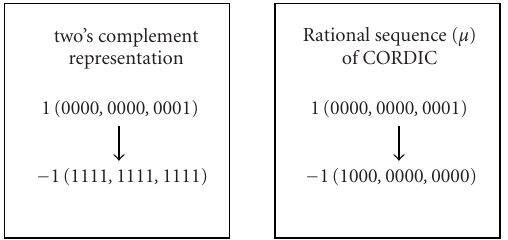
Figure 7: Switch activity in two’s complement representation and CORDIC